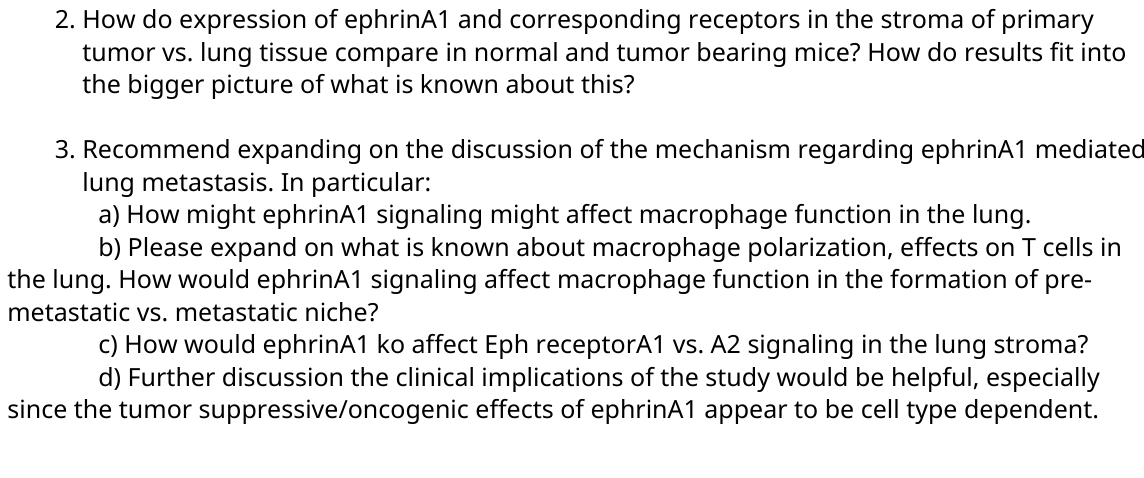
Figure 5: recommend revising figure legend. From the way the figure legend is stated “ Ephrin-A1-deficient lung microenvironment provides a less favorable metastatic niche ,” I would expect data correlating decreased metastasis with changes in the lung microenvironment of ephinA1 KO mice. However, this is not the case - no changes in endothelial cells were observed. Alternatively, for Figures 3 and 5 -